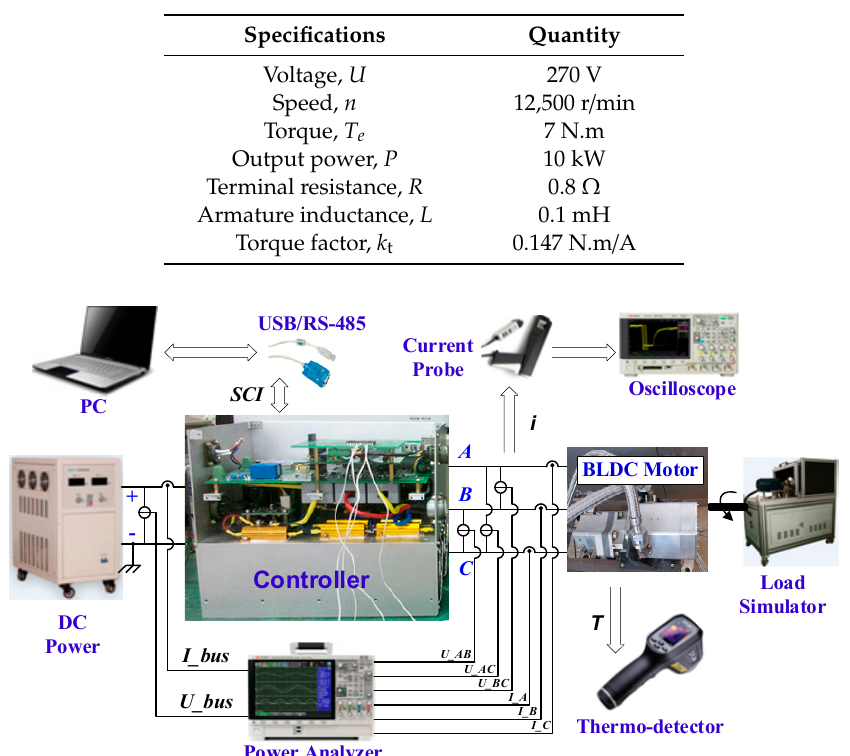
Figure 10. Prototype and the required equipment.